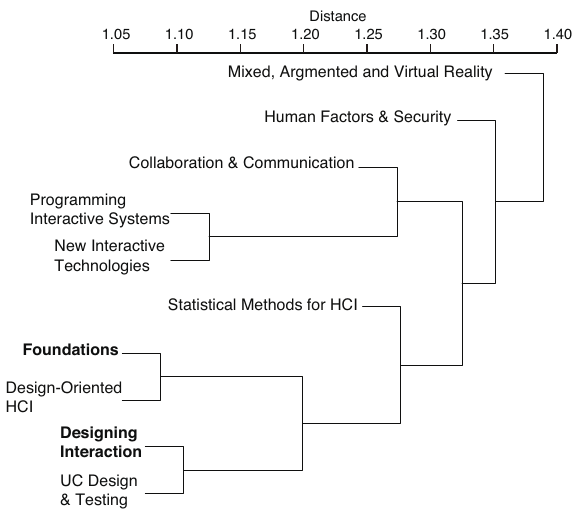
Figure 1. a dedrogram of an HCI guideline in CS2013 Table 3. Domains for AECT curriculum